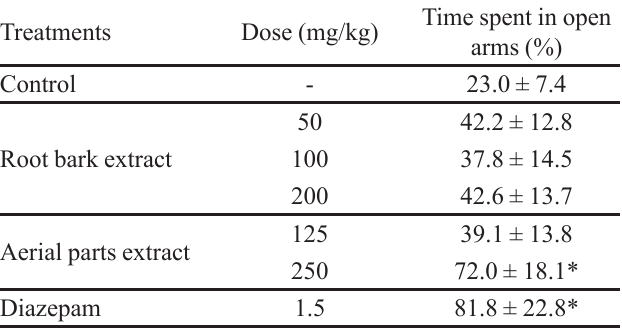
TABLE V - Time spent in open arms of the elevated plus maze after exposure to D. americana